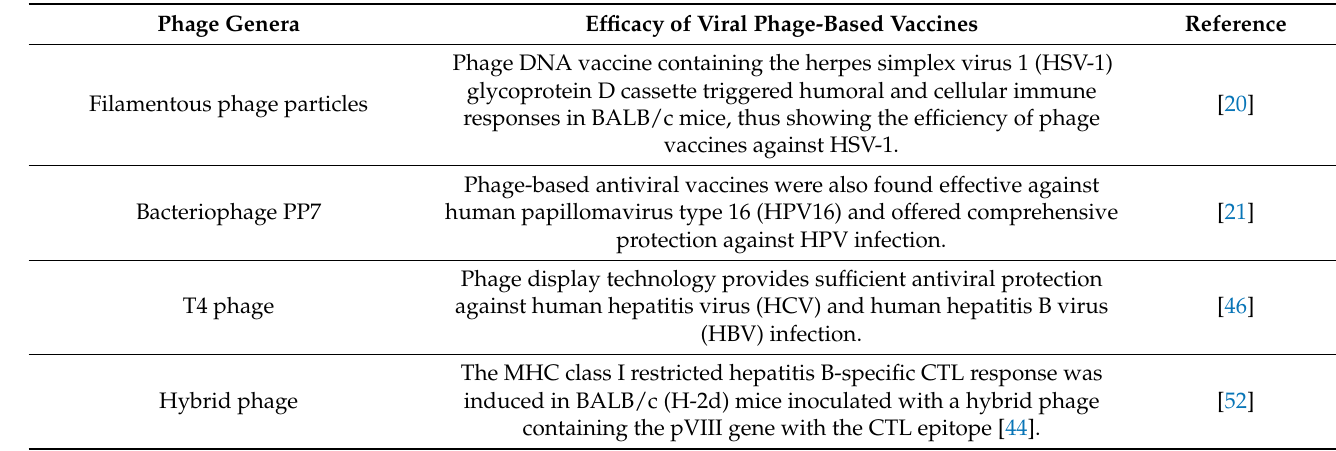
Table 1. Overview of phage-based vaccine/immunizations with antiviral efficacies against deadly pathogenic viral